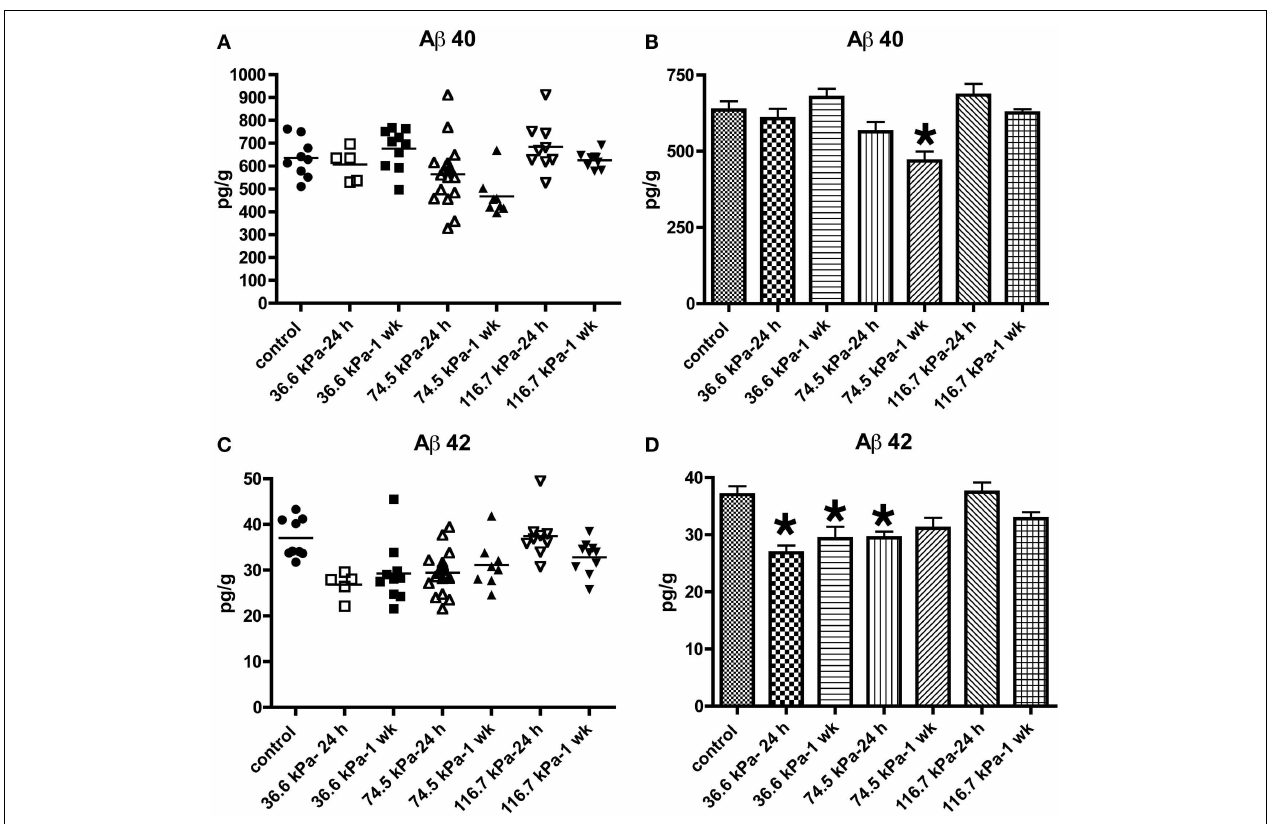
control group ( n = 9). Numbers of samples in each group are indicated in Table 1 .Values are presented ± the SEM. Asterisk indicates values that were significantly different from controls based on Dunnett’s test. Note the decrease in A β 42 in rats exposed to a 36.6kPa blast at 24h and 1week post-exposure as well as 74.5kPa exposed rats at 24h. By contrast A β 40 was decreased in only the 74.5kPa exposed rats at 1week. Further statistical comparisons are discussed in the text and presented in Table 1